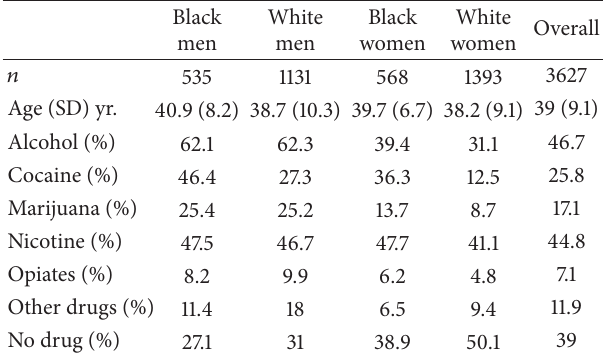
Table 1: Descriptive statistics of the key variables in the SAGE dataset stratified by sex and